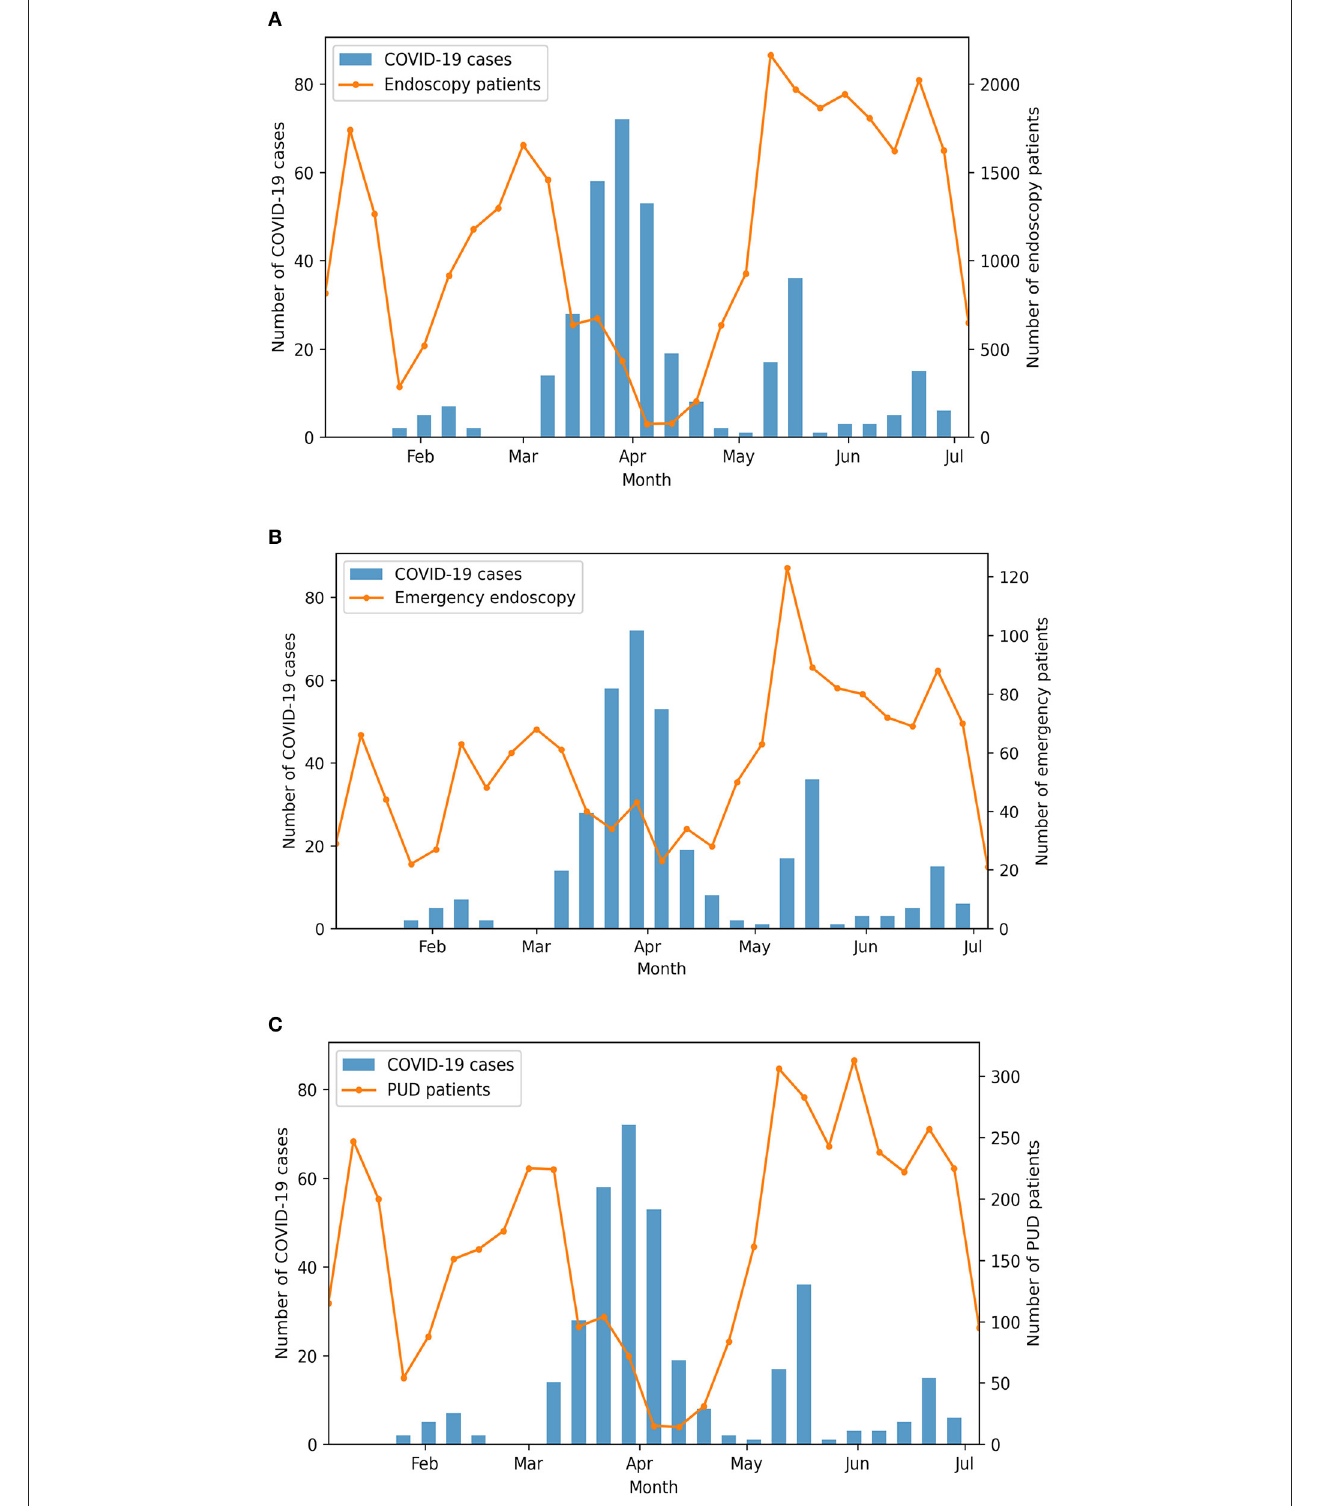
FIGURE 1 | The weekly number of upper gastrointestinal (GI) endoscopy (A) , GI emergency endoscopy (B) , and peptic ulcer disease (PUD) (C) compared against the weekly number of new coronavirus disease 2019 (COVID-19) cases.